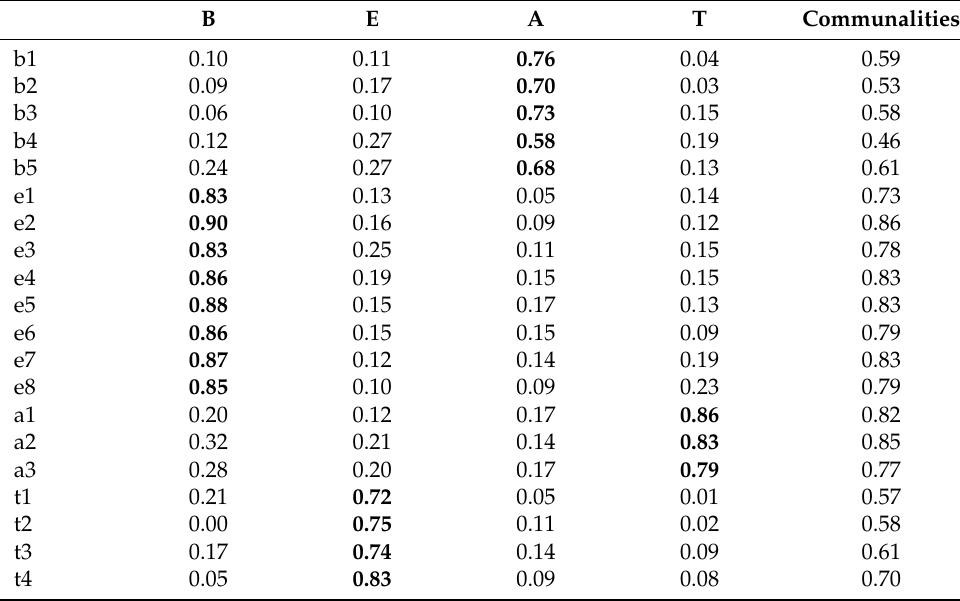
Table 2. Factorial loadings after varimax